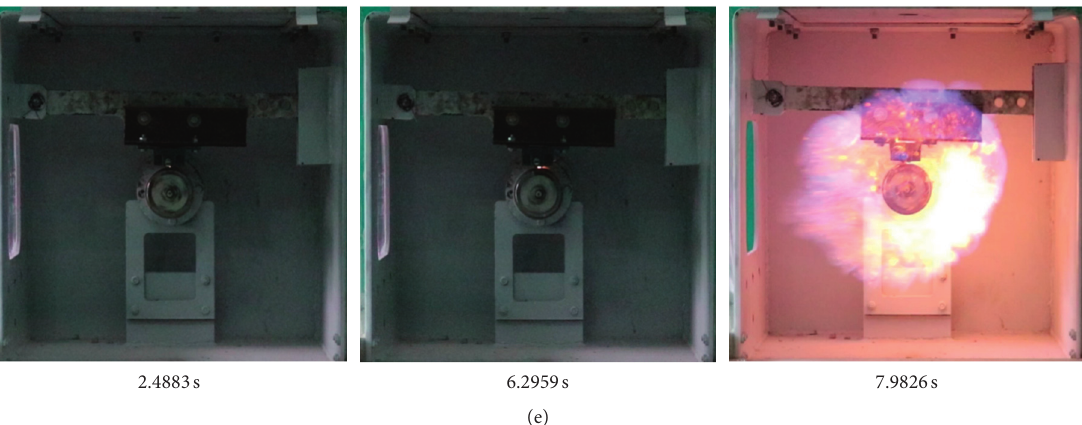
Figure 9: Typical experimental phenomenon of different methane concentrations. (a) 4.3% VOL. (b) 6.0% VOL. (c) 8.6% VOL. (d) 10.3% VOL. (e) 12.0% VOL. Table 2: Statistics of point spark, spark beam, and reaction time node of gas explosion at different gas concentrations. Gas